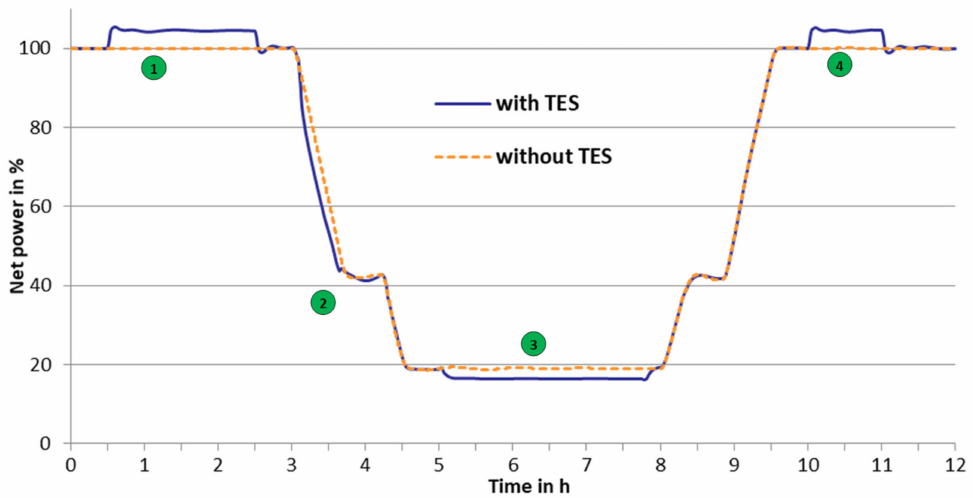
Figure 4. Course of net power over the entire simulation period (concept